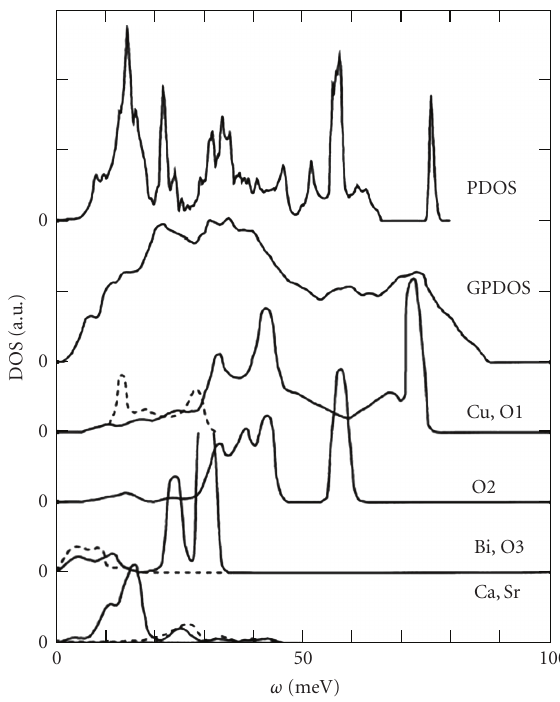
Figure 24: The spectral functions α 2 F ( ω ) from the tunnelling conductance of Bi 2 Sr 2 CaCu 2 O 8 for the positive and the negative bias voltages, and the averaged one [46, 47]. The averaged one is divided into 13 components. The origin of the ordinate is 2,1,0, and − 0 . 5 from the top down. From [46, 47, 53, 54].